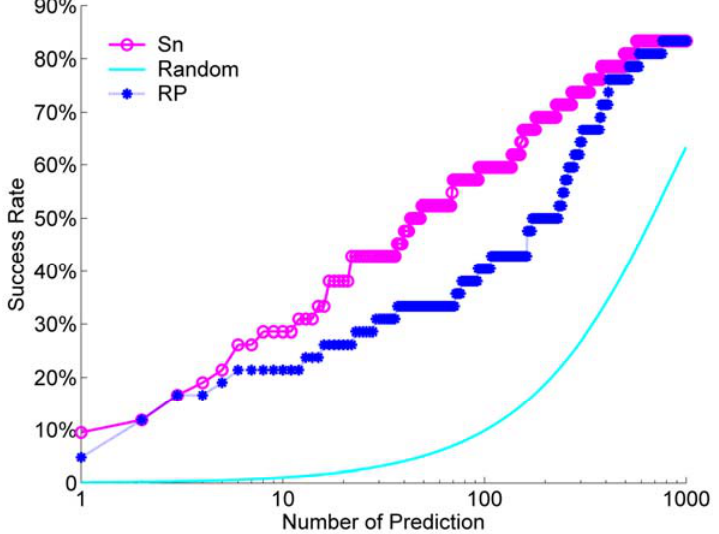
Figure 9. For the unbound dock results, the comparison of the success rate between the Sn scoring function, RP scoring function and a random